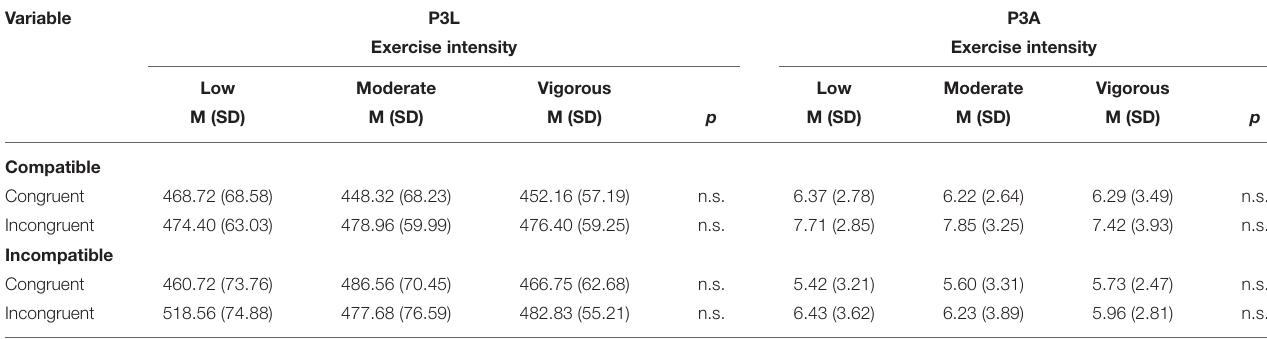
TABLE 4 | Mean (SD) of event-related brain potential (ERP) data.